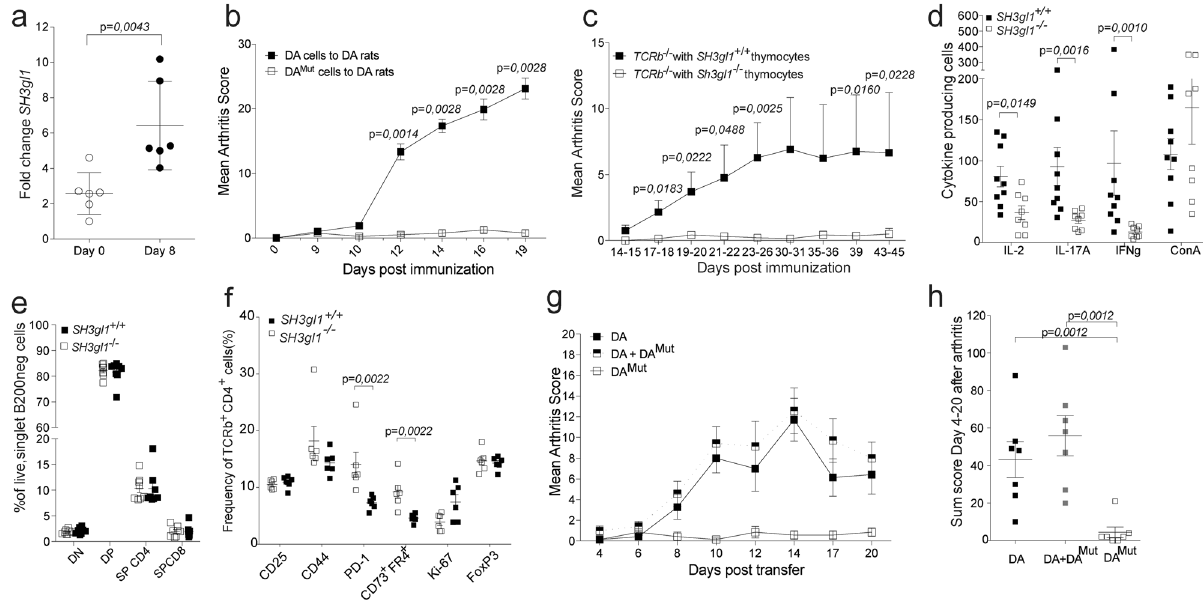
Fig. 3 T cells regulate Endophilin A2 mediated protection against arthritis. a Expression of SH3gl1 in sorted T cells from lymph nodes from DA rats at Day 0 and Day 8 after pristane immunization. b Mean arthritis score after adoptive transfer of pristane-primed DA and DA Mut cells to 9 respectively 4 naïve DA recipients. The adoptive transfer experiment has been reproduced a total of three times with the same results. c Mean arthritis score after GPI-induced arthritis in 17 and 19 TCR β knockout recipients that had received either SH3gl1 − / − or SH3gl1 + / + thymocytes respectively, 7 days prior to disease induction. Data is pooled from three individual experiments. d Number of antigen speci fi c IL-2, IL-17A and IFNg producing T cells after recall stimulation with GPI peptide and IL-2 producing cells after ConA stimulation day 44 after GPI-induced arthritis. Data from 9 TCR β knockout mice reconstituted with wild-type T cells and 8 TCR β knockout mice reconstituted SH3gl1 T cells. Recall experiment has been repeated twice in SH3gl1 − / − mice. e Frequency of double negative (DN), double positive (DP), single positive CD4 (SP CD4), and single positive CD8 (SP CD8) thymocytes in 8 SH3gl1 − / − and 8 SH3gl1 + / + mice. Data has been reproduced twice. f Frequency of CD25, CD44, PD-1, CD73 + FR4 + , Ki-67, and FoxP3 positive cells in CD4 + TCRb + cells from inguinal lymph nodes ten days after GPI-peptide immunization from 6 SH3gl1 − / − and 6 SH3gl1 + / + mice. g Mean arthritis score in naïve DA recipients after adoptive transfer of pristane-primed DA Mut cells only, DA cells only or DA cells in addition with DA Mut cells, 7 rats per group. h Arthritis sum score of the DA recipients above after adoptive transfer of pristane-primed DA cells only or addition with DA Mut cells, 7 rats per group. Non-parametrical Mann – Whitney U test was used for statistical evaluation of data. Data are presented as mean with error bars indicating ±SEM with each dot representing an individual